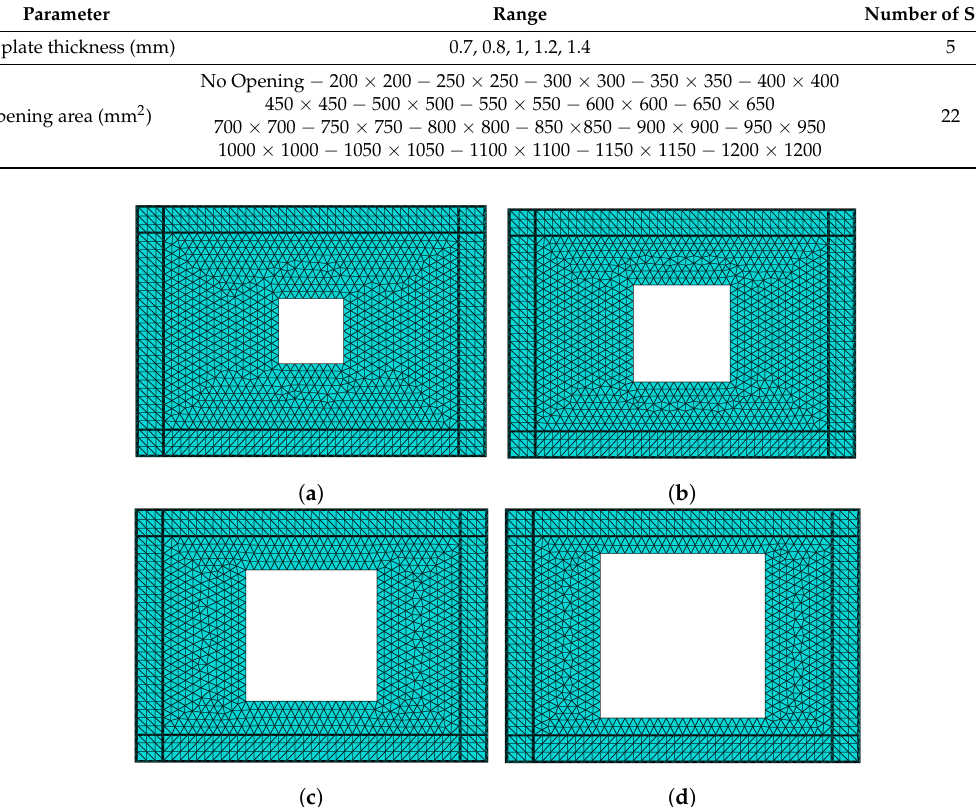
Figure 5. The numerical model of ( a ) R400 ( b ) R600 ( c ) R800 ( d )